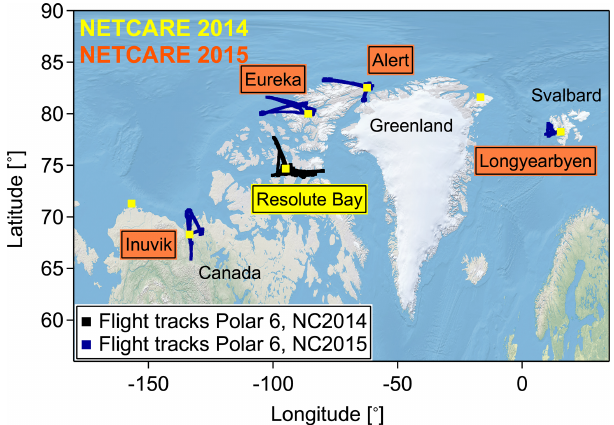
Figure 1. Compilation of research flight tracks during two NET- CARE airborne field campaigns in July 2014 and April